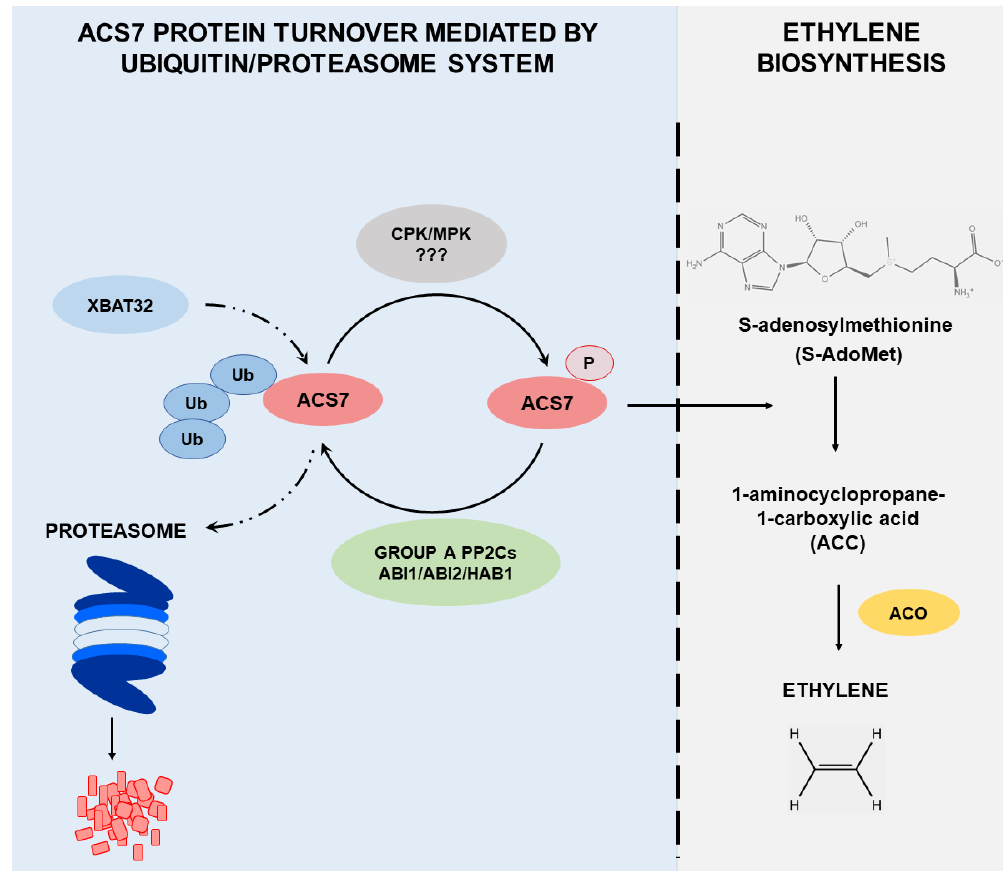
Figure 8. Overview of the regulation of ACS7 protein turnover. ACS7 is the only type III ACC synthase in Arabidopsis and is characterized by a unique structure with no regulatory domains, despite the fact that ACS7 protein undergoes proteasomal degradation. Phosphorylation mediated by CDPK and/or MAP kinases results in ACS7 activation and an increase in ethylene biosynthesis. Protein phosphatases type A (ABI1, ABI2 and HAB1) remove the phosphate group from ACS7, which in turn inhibits its activity and promotes ubiquitination mediated by the XBAT32 E3 ubiquitin ligase. After ubiquitination, ACS7 is immediately directed for degradation via the proteasome pathway, and ethylene biosynthesis driven by ACS7 is thus restricted.